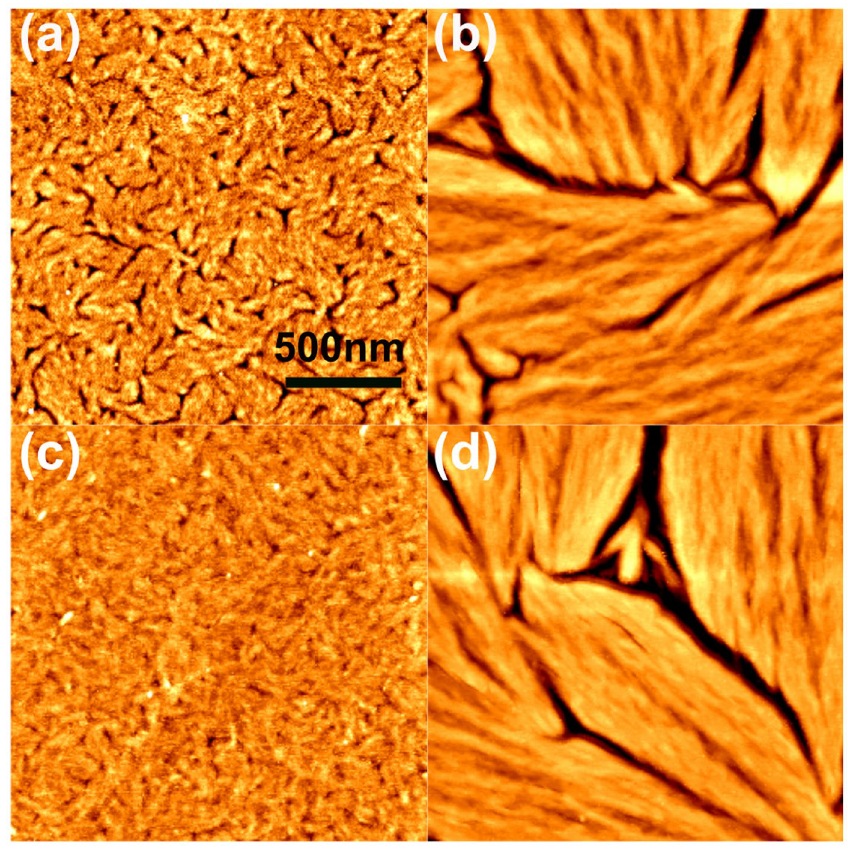
Figure 4. Atomic force microscopy imaging of the as-spun organic films for ( a ) LGC-D117, ( b ) LGC-D118 and of films annealed at 140 °C for ( c ) LGC-D117, ( d )